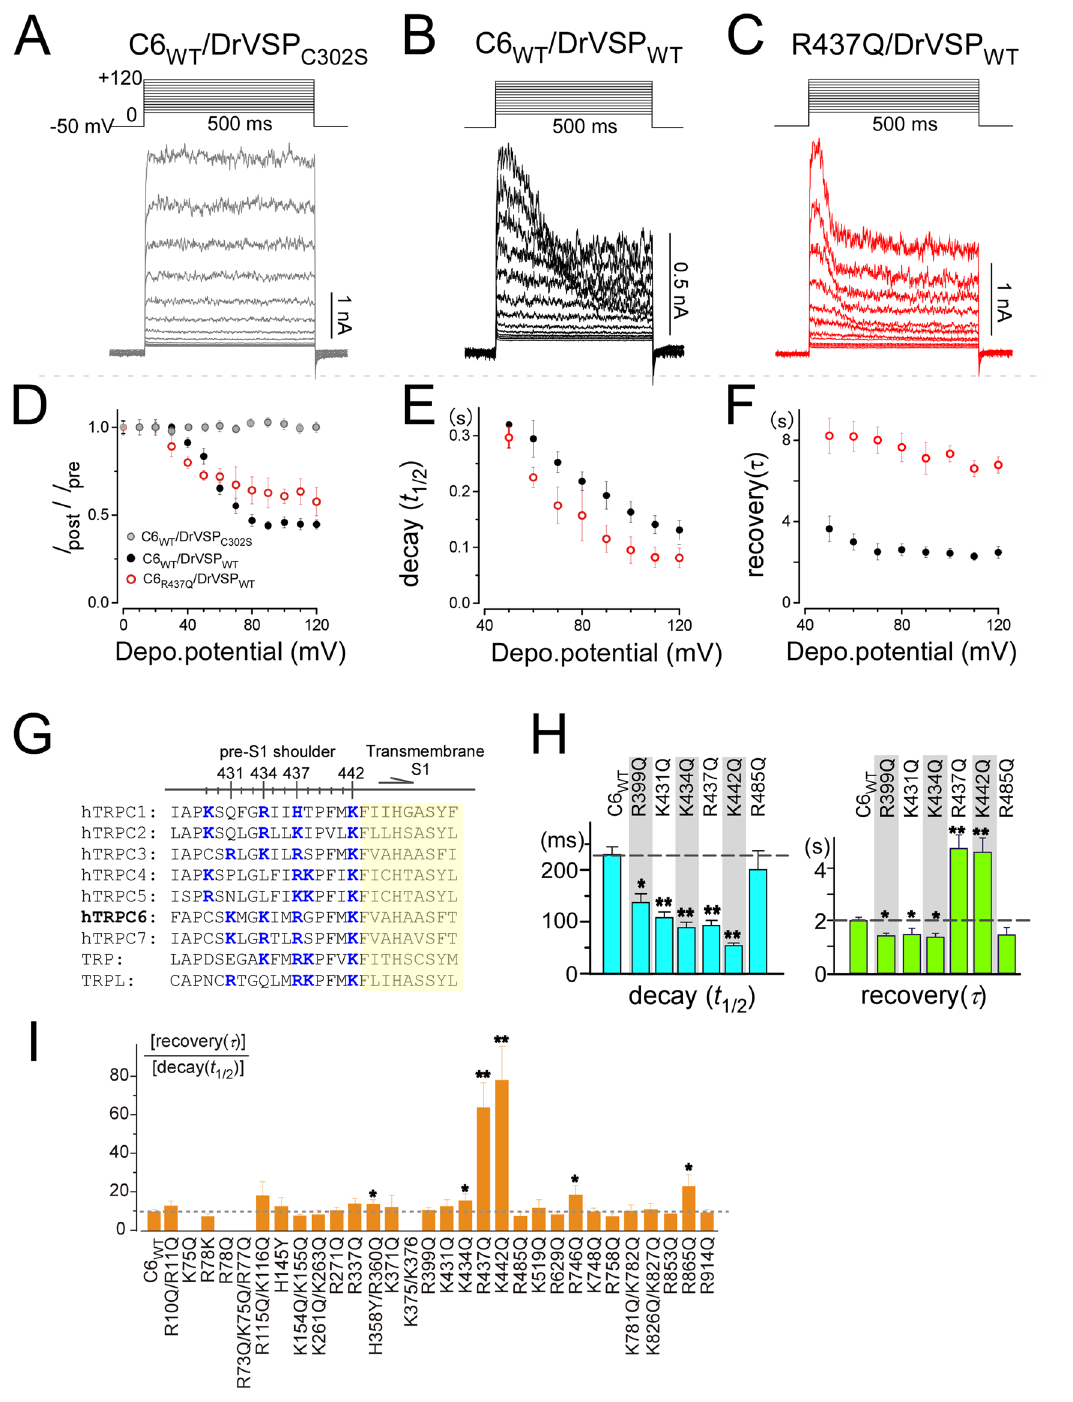
Figure 3. Basic residues in the pre-S1 domain/shoulder are critical for PIP 2 binding. Voltage-step pulses in HEK293 cells co-expressing TRPC6 WT and DrVSP mutant ( A ) or TRPC6 WT or TRPC6 R437Q and DrVSP WT ( B , C ). ( D – F ) Summary of the voltage-step pulse results. ( D ) I post / I pre , ( E ) PIP 2 deactivation kinetics, ( F ) PIP 2 reactivation kinetics. ( G ) Sequence alignment of the pre-S1 shoulder from human TRPC and Drosophila TRP channels. Positively charged residues are shown in blue. The numbering is based on human TRPC6 channel. ( H ) PIP 2 deactivation and reactivation kinetics after charge neutralization mutation of the TRPC6 pre-S1 shoulder. The voltage pulse protocol is identical that in Fig. 2. ( I ) Ratio of the reactivation/deactivation kinetics for estimation of dissociation strength. The R437Q and K442Q mutants showed significantly reduced interaction with PIP 2 (* p < 0.05 or ** p <